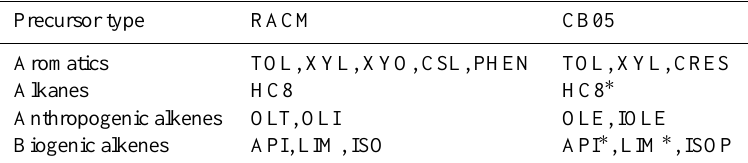
Table 2. Gas-phase organic precursors in the two mechanisms. Precursor type RACM CB05 Aromatics TOL, XYL, XYO, CSL, PHEN TOL, XYL, CRES Alkanes HC8 OLT,